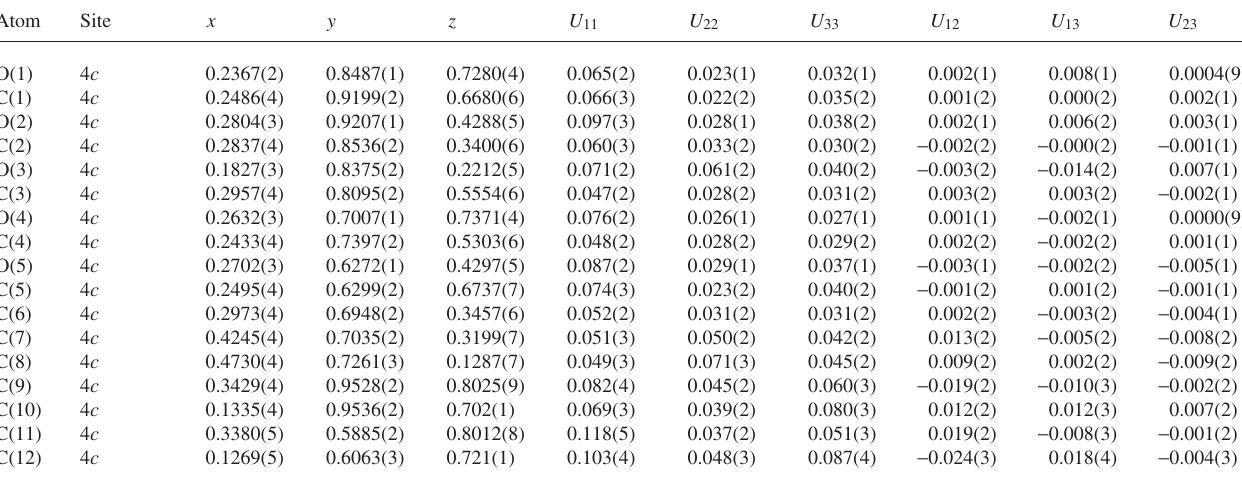
Table 3. Atomic coordinates and displacement parameters (in Å 2 )